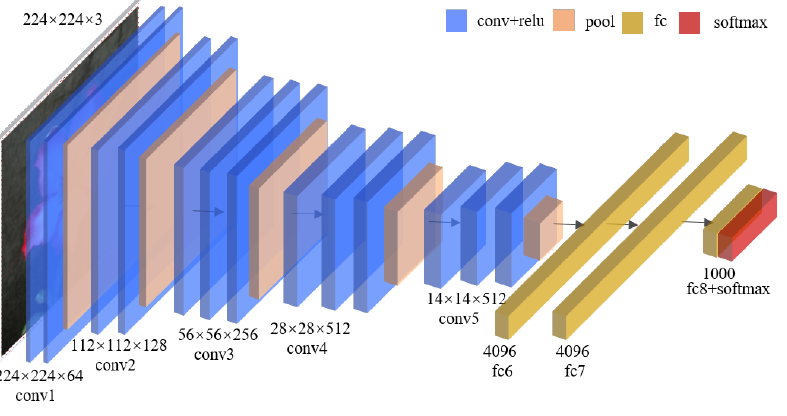
Figure 2. The architecture of